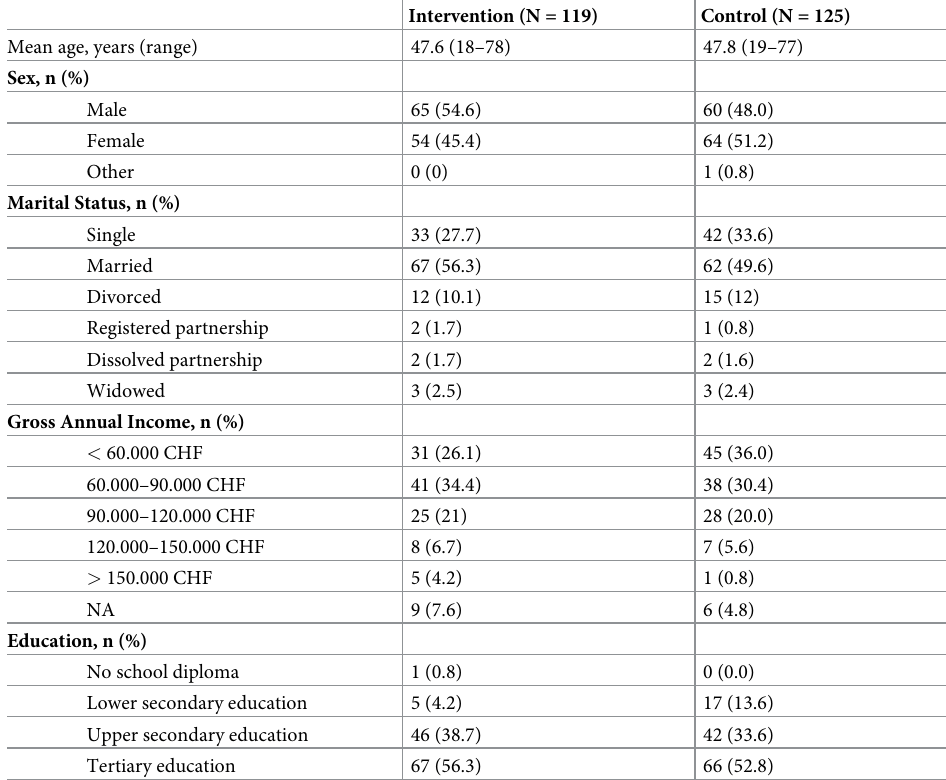
Table 1. Demographics of participants in the randomized controlled trial by condition.